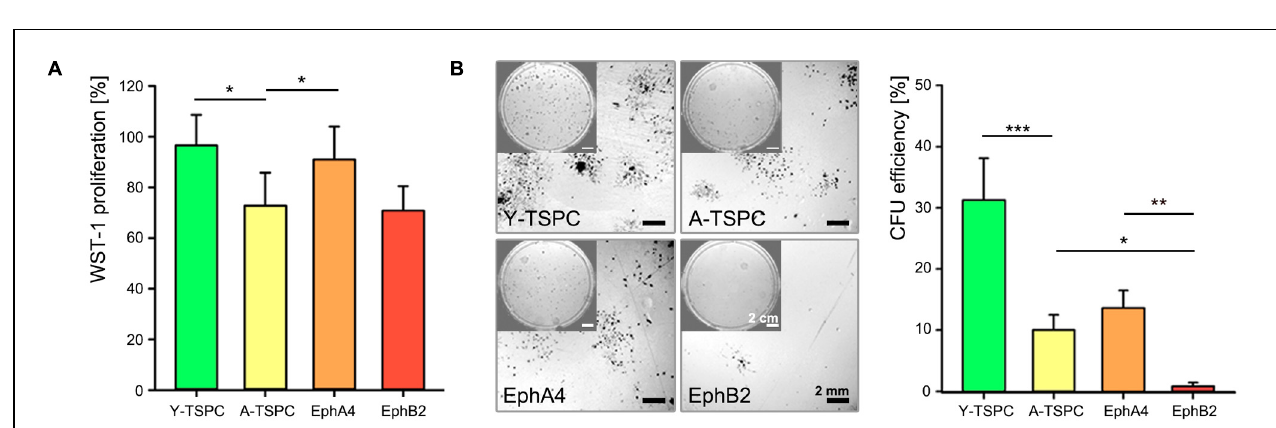
FIGURE 3 | Self-renewal potential of EphA4-Fc and EphB2-Fc A-TSPC. (A) WST-1 proliferation and (B) CFU analysis of Y-TSCP, EphA4-Fc, EphB2-Fc, and control-Fc A-TSPC. Data consists of three independent repeats with all three Y-and A-TSPC donors ( n = 9, ∗ p < 0.05; ∗∗ p < 0.01; ∗∗∗ p < 0.001).